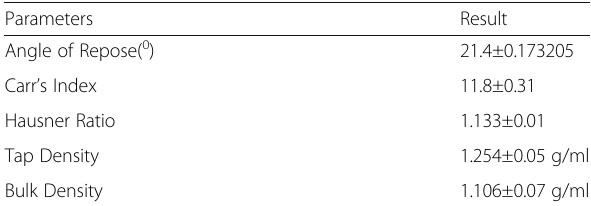
Table 5 Micromeritic properties of Fenofibrate Co-crystal